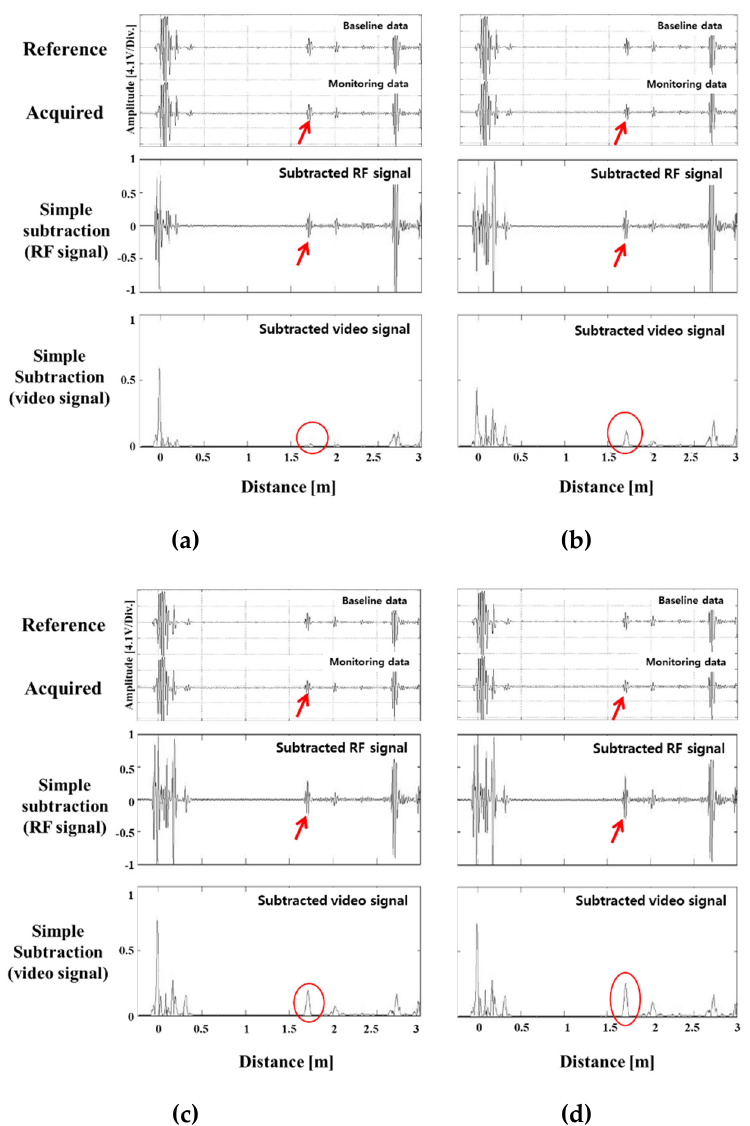
Figure 6. Notches with various depths in a pipe weld: ( a ) 5%, ( b ) 10%, ( c ) 20% and ( d ) 30% of pipe wall thickness. The reference signal (top), acquired signals (middle), and signals after simple subtraction